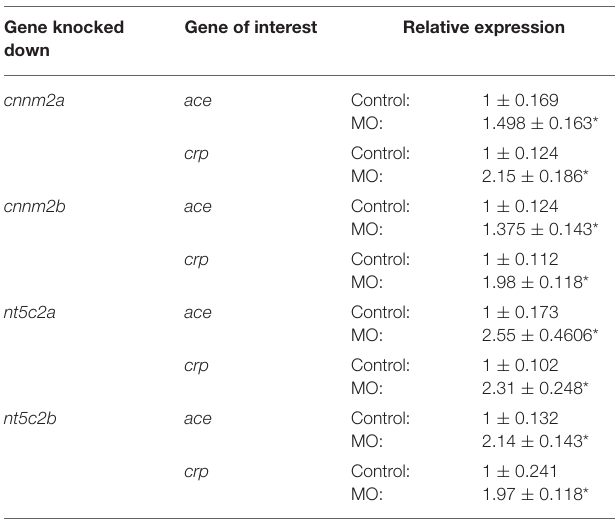
TABLE 2 | Gene expression of hypertension and inflammation markers, i.e., ace and crp , post morpholino knockdown of cnnm2a, cnnm2b, nt5c2a , and nt5c2b genes in